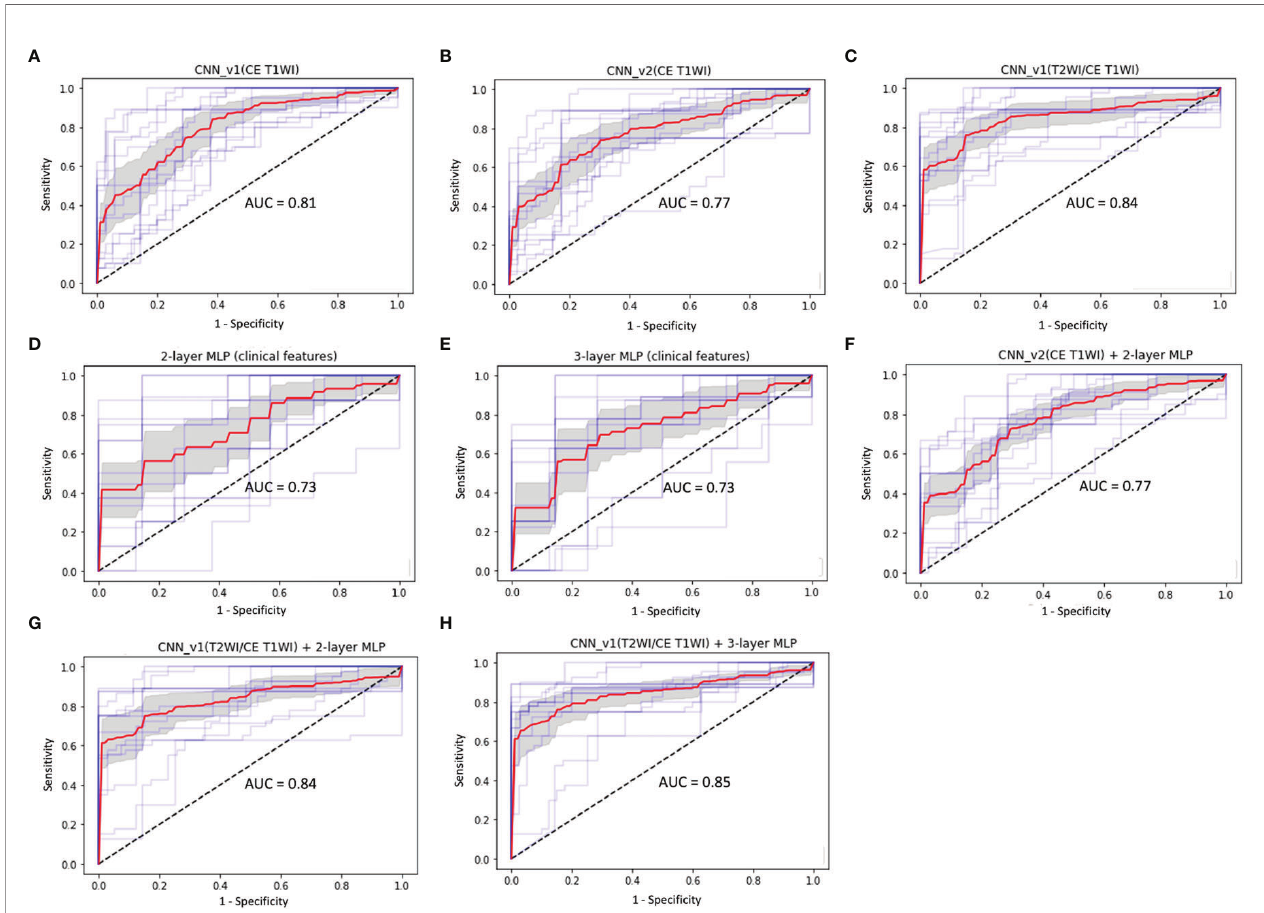
FIGURE 5 | ROC curves (red: average, blue: 5 folds for cross-validation, gray: 95% con fi dence interval) and AUC values in (A) CNN_v1 (CE T1WI), (B) CNN_v2 (CE T1WI), (C) CNN_v1 (T2WI/CE T1WI), (D) 2-layer MLP (clinical features), (E) 3-layer MLP (clinical features), (F) multimodal CNN_v2 (CE T1WI) + 2-layer MLP, (G) multimodal CNN_v1 (T2WI/CE T1WI) + 2-layer MLP, and (H) multimodal CNN_v1 (T2WI/CE T1WI) + 3-layer MLP architectures for prediction of P/R in